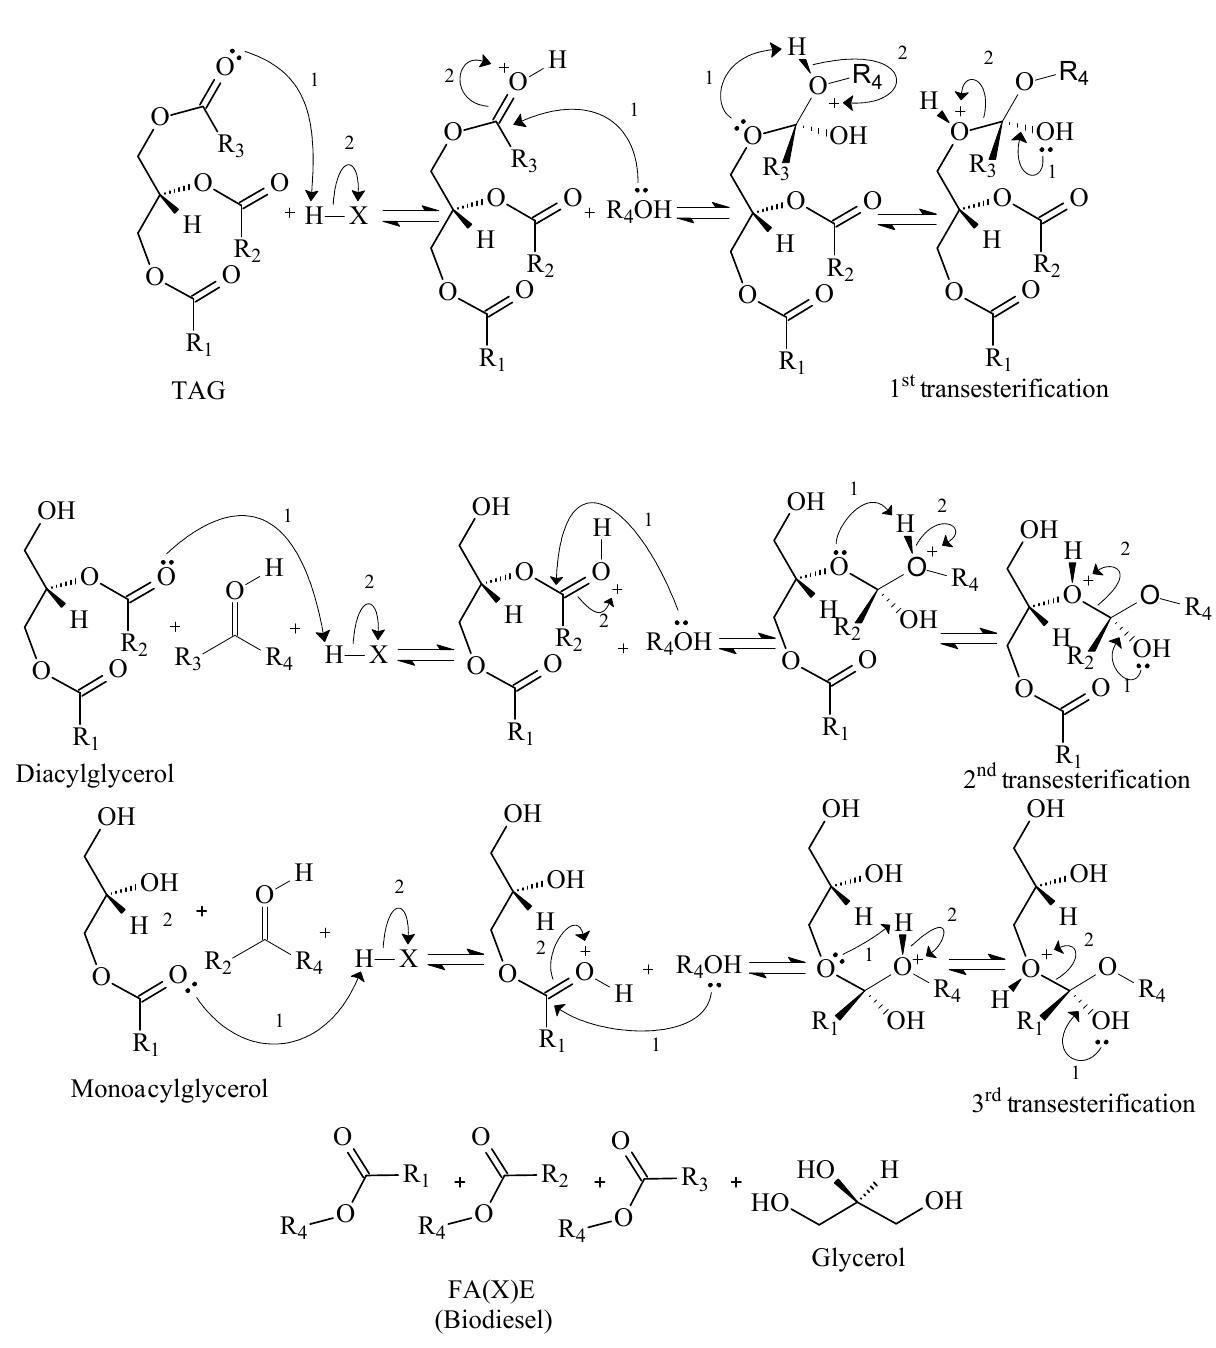
Figure 4. Generic acid reaction mechanism for conversion of TAG to FA(X)E.